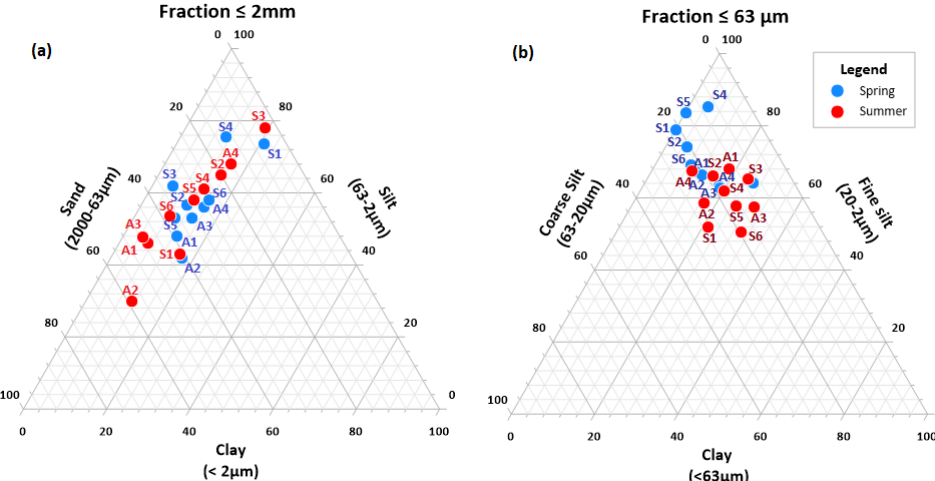
Figure 2. Mean respective proportion of particle size distribution of the sediments collected in the Sebou basin during spring (blue) and summer (red) seasons. ( a ) Ternary plot of the total fraction ≤ 2000 µ m (Sands, 2000–63 µ m; silts, 63–2 µ m and clays, ≤ 2 µ m). ( b ) Ternary plot of the fine fraction ≤ 63 µ m (Coarse silts 63–20 µ m, fine silts, 20–2 µ m and clay, ≤ 2 µ